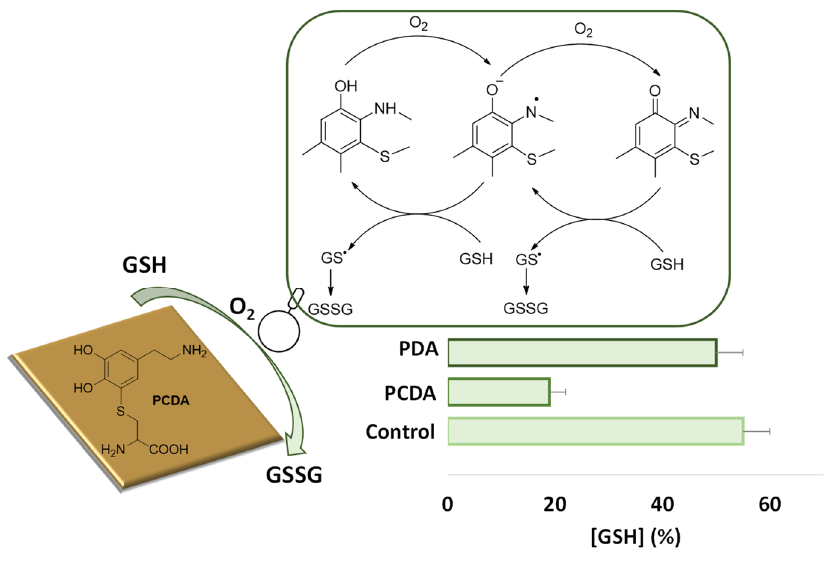
Figure 7. Effect of polycysteinyldopamine (PCDA) or polydopamine (PDA) thin films on the autoxidation of GSH after 3 h incubation in phosphate buffer pH 7.4. The redox cycling mechanism supposedly involved in PCDA prooxidant properties toward GSH is also shown.